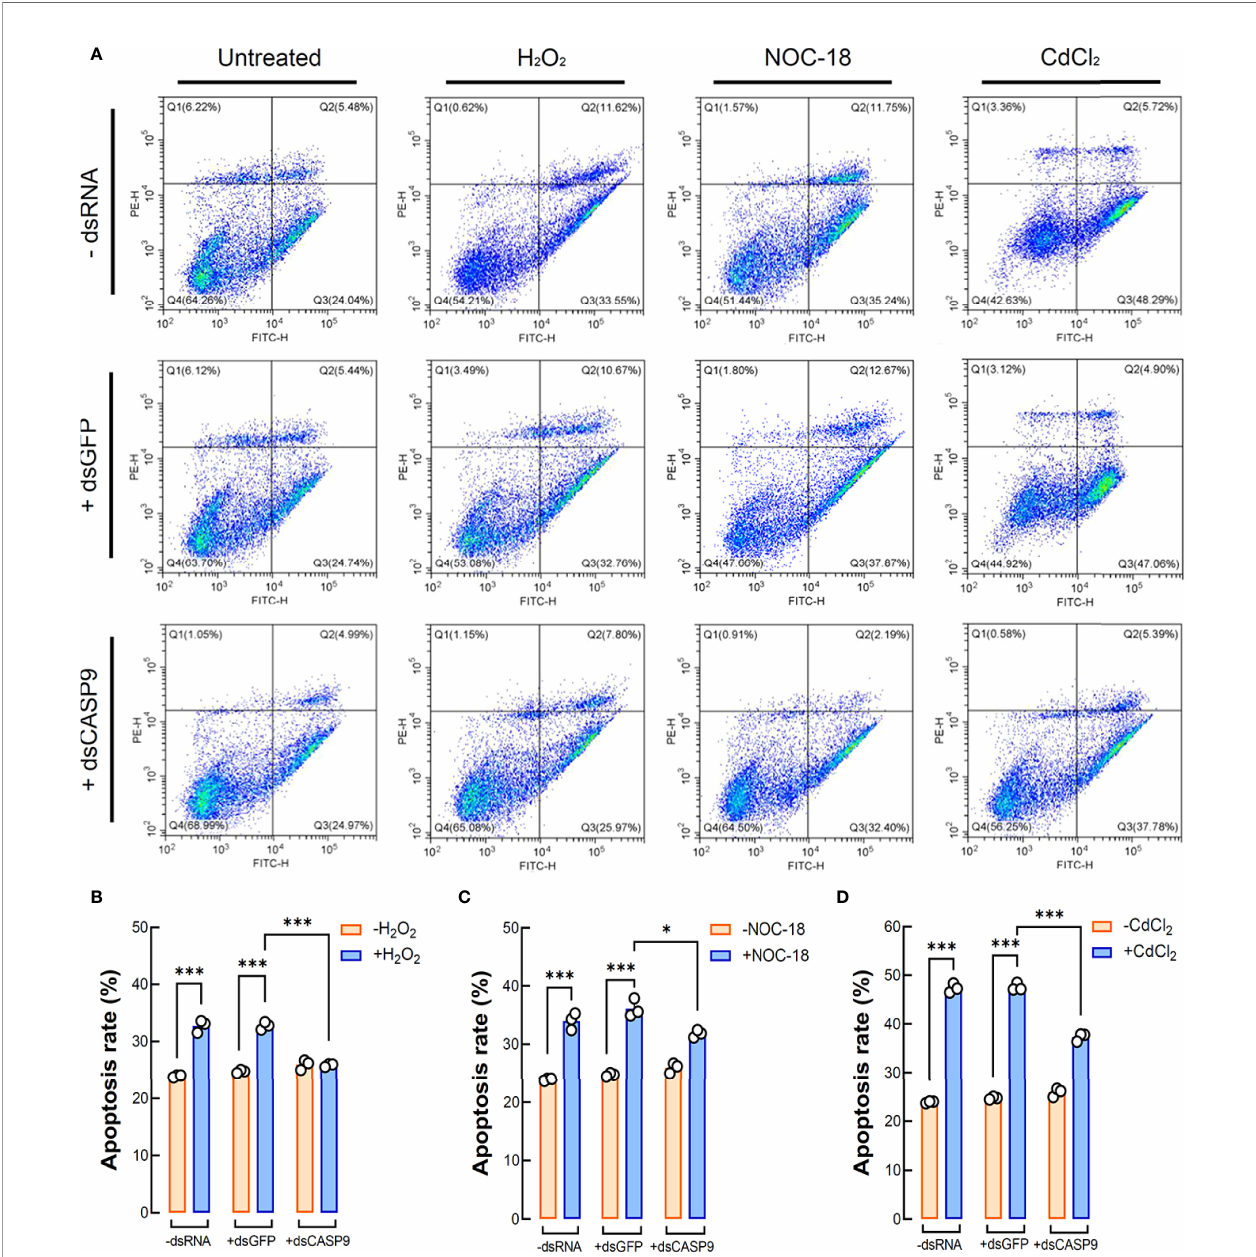
FIGURE 6 | Coelomocyte apoptosis analysis by fl ow cytometry following Hl-CASP9 knock-down in vivo. (A) Coelomocytes treated with the indicated stimulants including H 2 O 2 (2 m M), NOC-18 (1 m M) or CdCl 2 (20 m M). Effects are compared among the “ -dsRNA ” group (sea cucumber injected of RNase-free saline solution), “ +dsGFP ” group (sea cucumber injected of dsGFP) and “ +dsCASP9 ” group (sea cucumber injected of dsCASP9). (B) Statistical analysis on mean rates of early apoptosis in coelomocytes exposed to H 2 O 2 (2 m M) for 24 h in different groups. (C) Statistical analysis on mean rates of early apoptosis in coelomocytes exposed to NOC-18 (1 m M) for 24 h in different groups. (D) Statistical analysis on mean rates of early apoptosis in coelomocytes exposed to CdCl 2 (20 m M) for 24 h in different